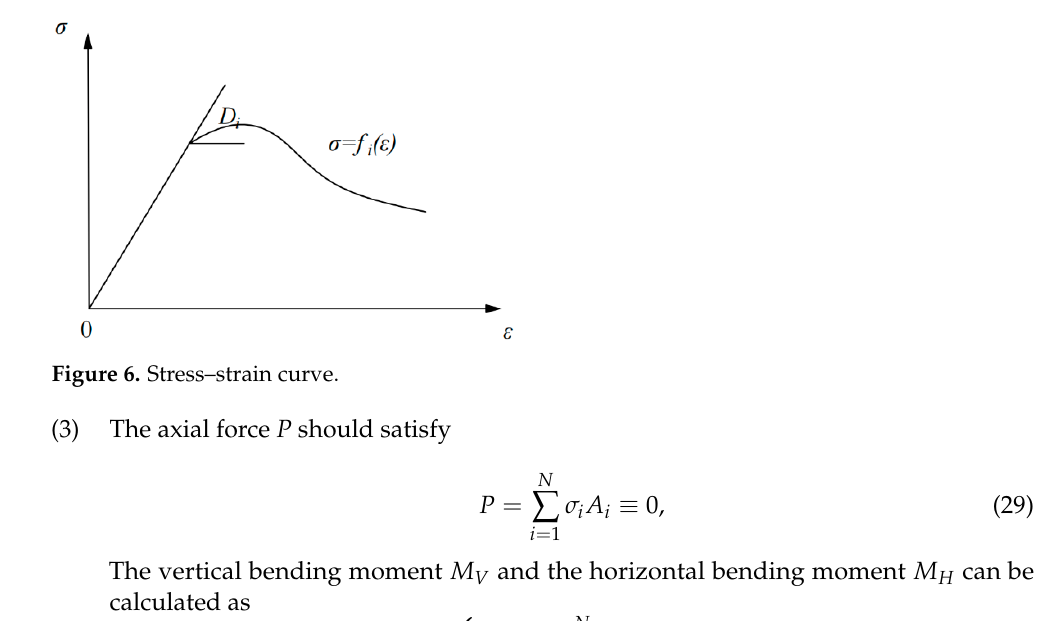
11 of 18 Figure 4. Accuracy comparison of fitting results for ( a ) TD1 in Case 1, ( b ) TD1 in Case 2, ( c ) TD2 in Case 1, ( d ) TD2 in Case 2, ( e ) TD3 in Case 1, ( f ) TD3 in Case 2, ( g ) TD4 in Case 1, and ( h ) TD4 in Case 2. 4. Calculation and Fitting for the Sample of the Damaged Ships 4.1. The Improved Smith Method In the improved Smith method [17], the rotation of the neutral axis can be taken into account, which makes it applicable to asymmetric hull girder, for instance, damaged hull like the cross-section in Figure 5 under combined bending moments. Figure 5. Cross section of a damaged ship. The process for calculating the residual strength consists of 10 steps [3]: (1) The cross section of concern is divided into different types of stiffened plate units, plating units, and hard-corner units; (2) For a given curvature, the stress–strain relationships for all types of units are defined as shown in Figure 6. Then, the strain of the i -th unit is 0 ( , ) i